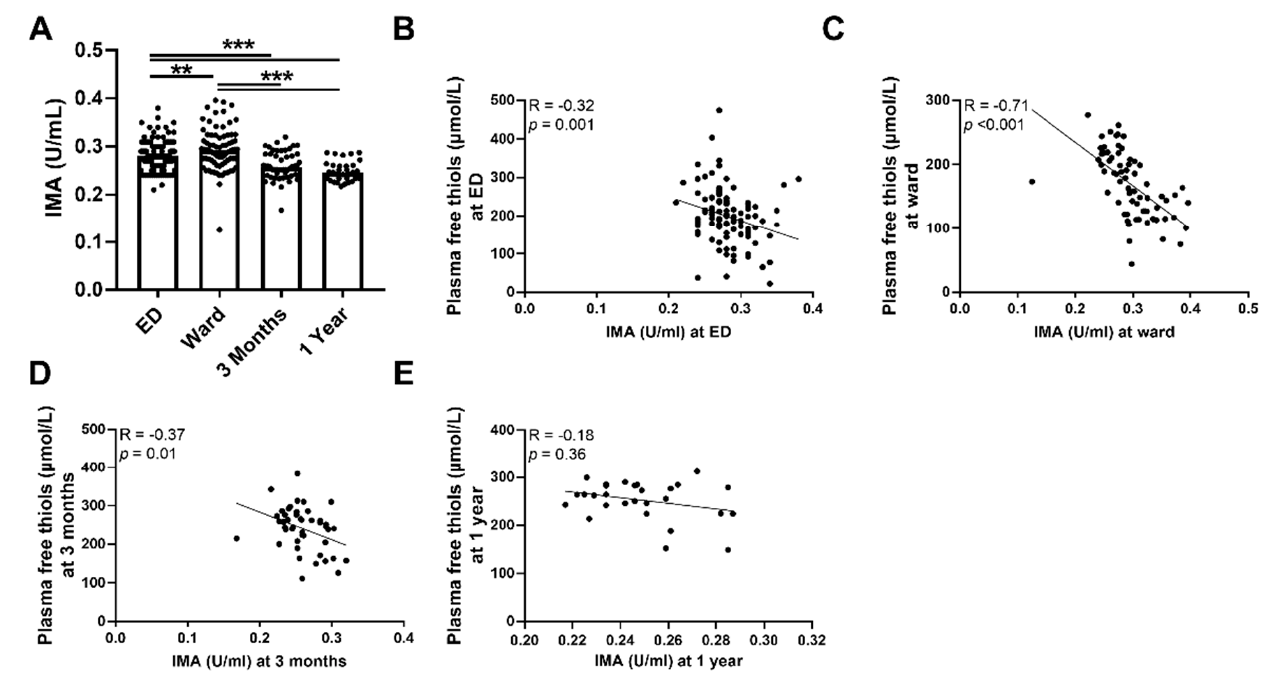
Figure 3. Course of IMA in septic patients and association with plasma free thiols. ( A ) IMA concentrations at the ED, the ward, and at three months and one year after hospital admission. ( B ) Correlation of IMA at the ED and plasma free t ian the ED. ( C ) Correlation of IMA at the ward and plasma free thiols at the ward. ( D ) Correlation of IMA at three months and plasma free thiols at three months. ( E ) Correlation of IMA at one year and plasma free thiols at one year. Statistical analyses were performed using Wilcoxon matched-pairs signed test. Bars represent the median; dots represent individual levels. ** means p < 0.01, *** p <0.001. ED: emergency department, IMA: ischemia- modified